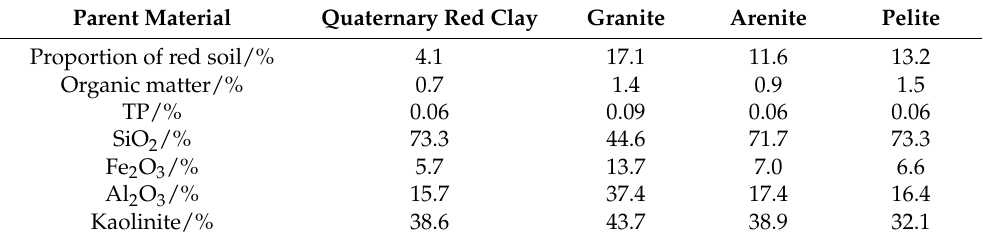
Table 3. Parent materials of red soil and its compositions proportion. Parent